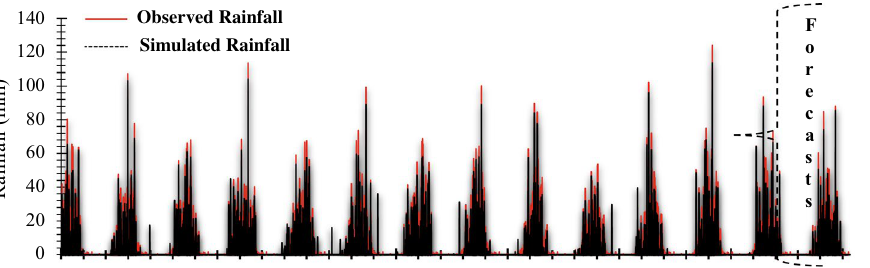
Fig. 5 Evolution of rainfall ensemble forecast against observations